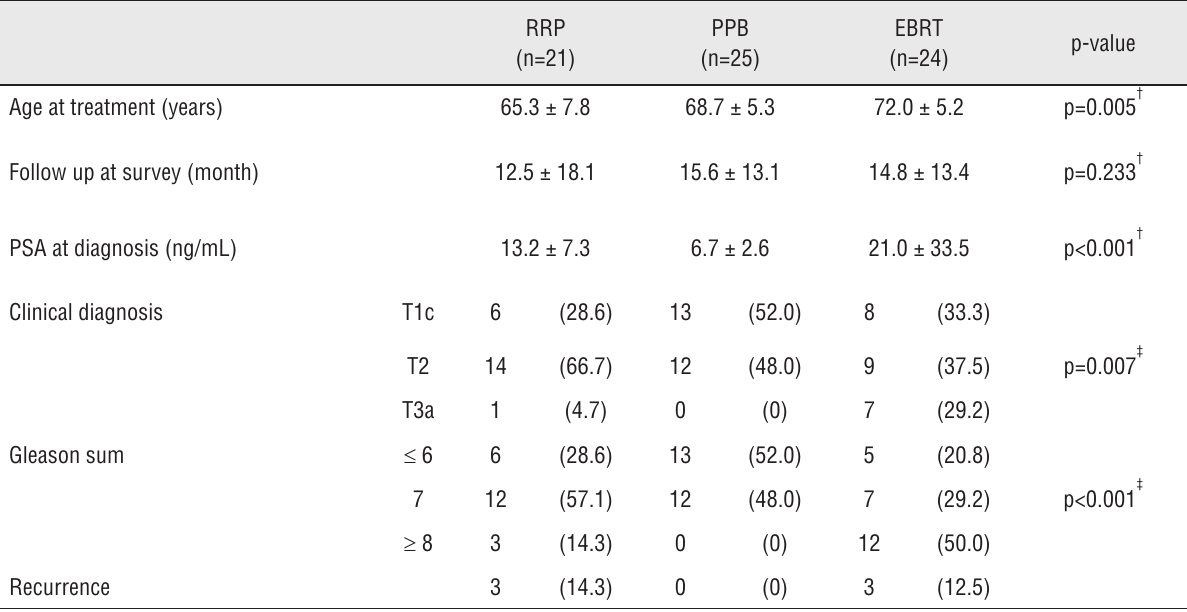
Table 1 - Clinical characteristics of study population.